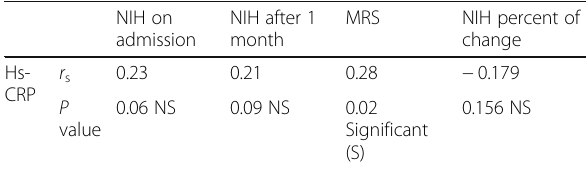
Table 10 Correlation between hs-CRP and NIH on admission, NIH after 1 month and MRS